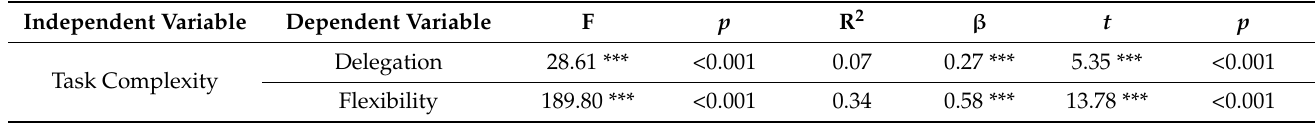
Table 5. Results of the two simple linear regressions